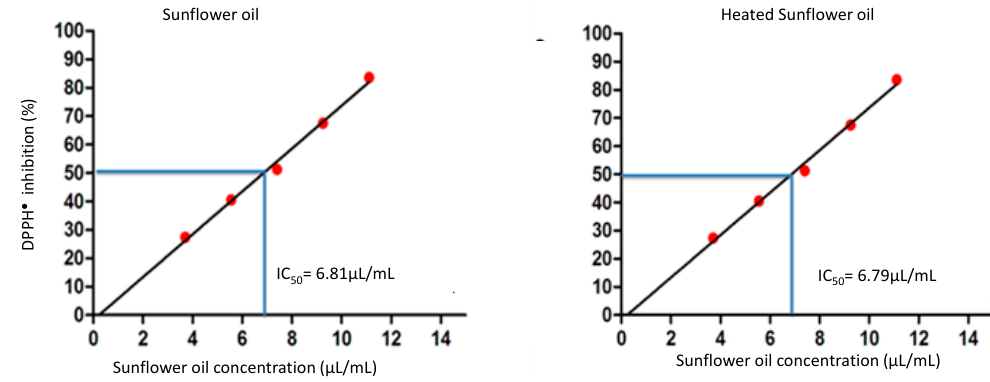
Figure 1. Determination of the activity of H + donor of sunflower oil and sunflower oil heated (75 ± 2 °C) to the DPPH ● .